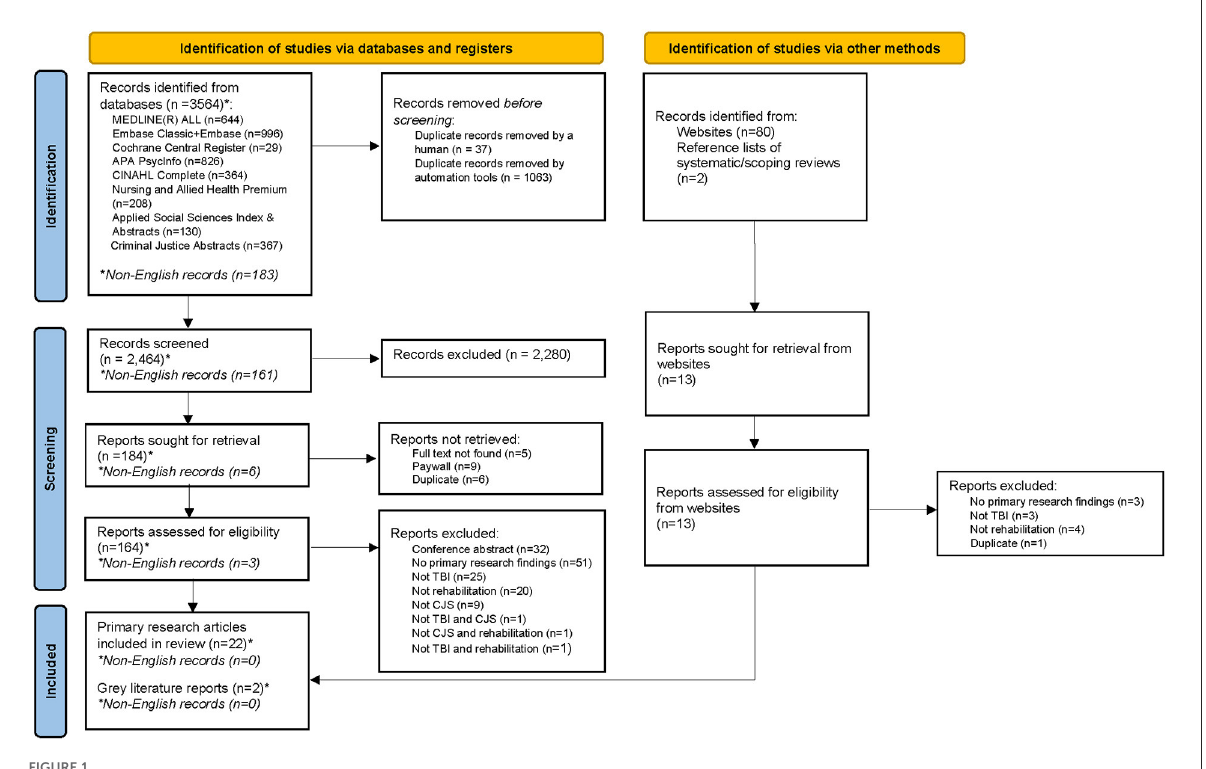
FIGURE1 PRISMA flow